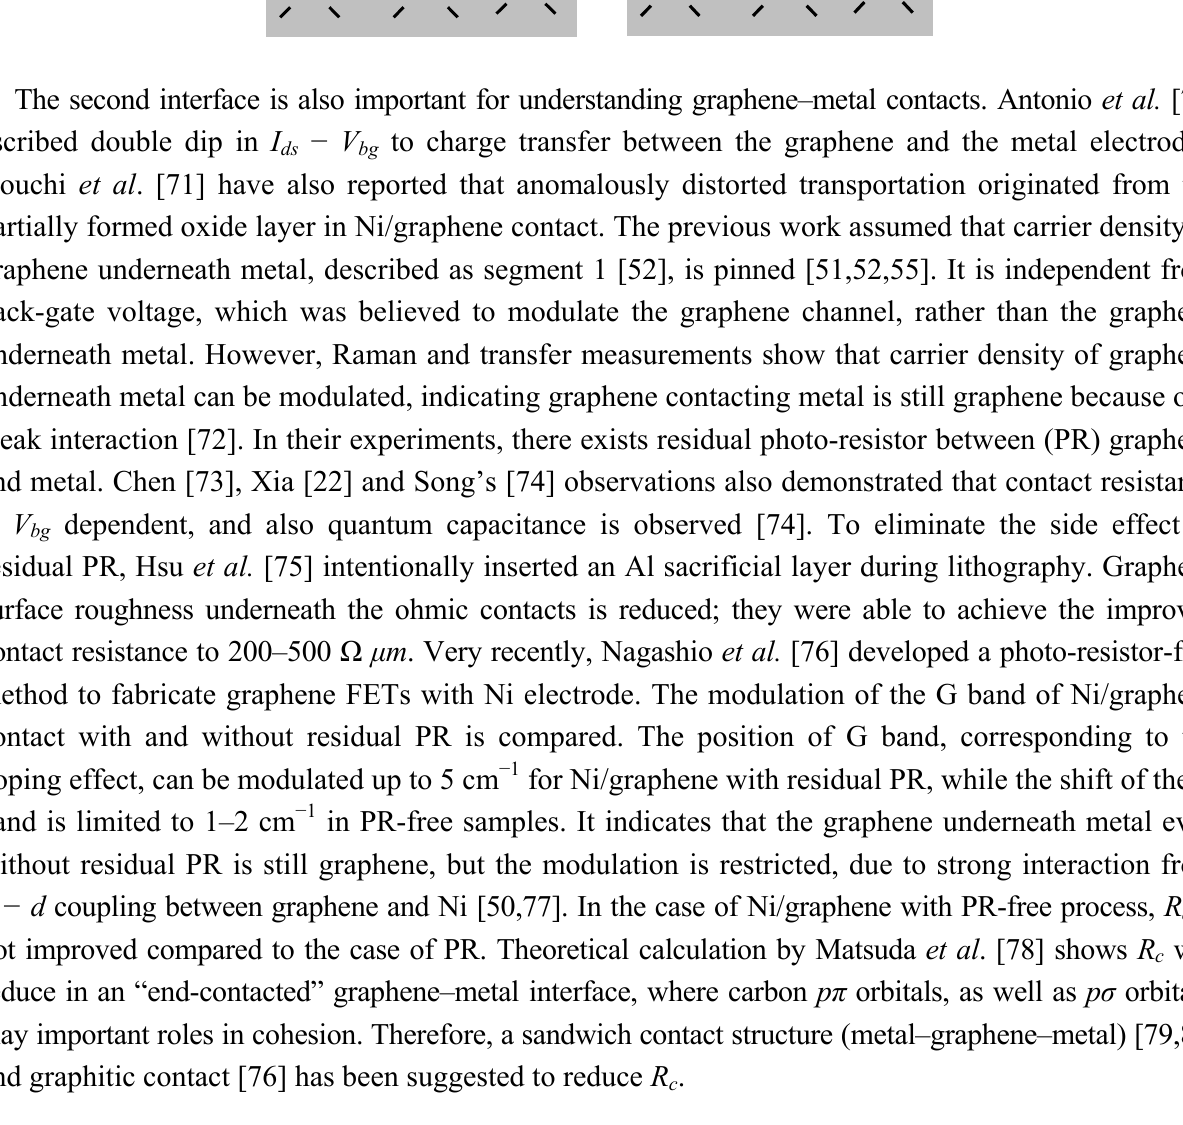
Figure 9. The schematics illustration of SiO and ( b ) re-oxidation process. After HF solution dipping, the SiO be terminated by OH bonds and some hydrocarbons (e.g., − CH reoxidation-treated sample, it is an O-terminated SiO